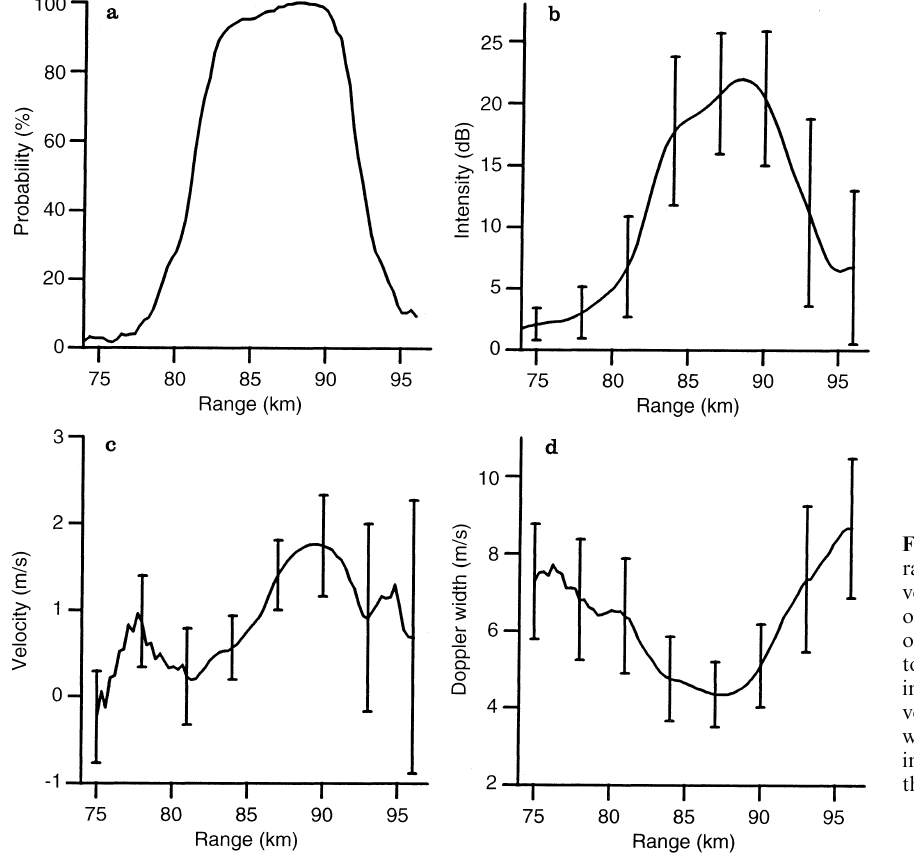
Fig. 2a–d. Averaged characteristics of radar echoes obtained on 25 July 1994 versus range. a Probability of echo observations calculated as a percentage of 30-s intervals when averaged signal- to-noise ratio was above 5 dB. b Mean intensity of the echoes. c Mean vertical velocities. d Mean Doppler spectral widths. Only data from echoes with intensity above 5 dB were averaged for the last